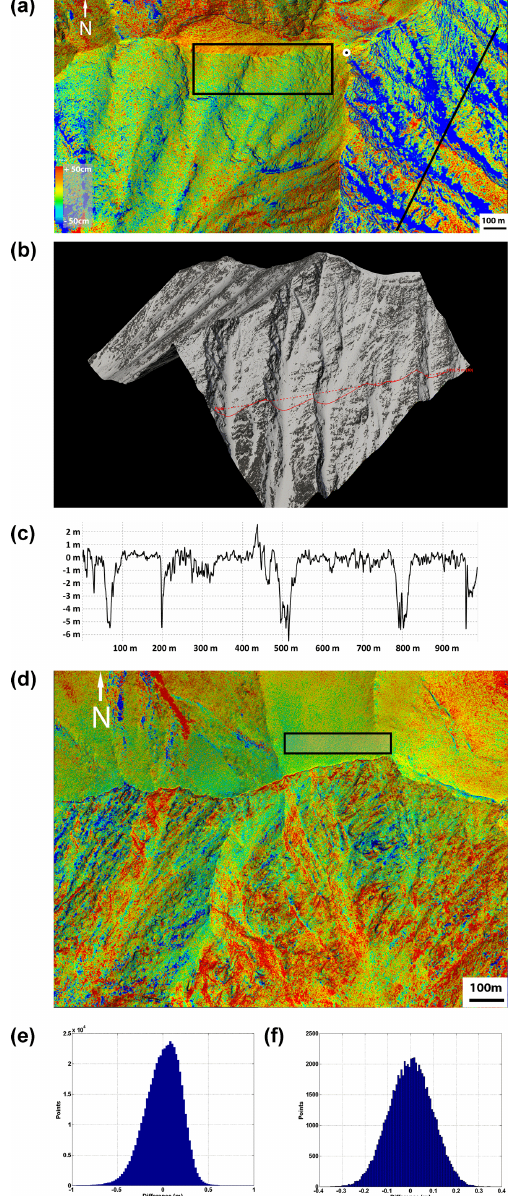
Figure 3. Precision assessments. (a) Difference in elevation between March and April 2014 acquisitions at Mt. Chamberlin, shown as a top view with slight sun shading to highlight underlying topography. Color represents change ( − 50 to + 50cm). The consistency of color shift between mountain faces is not due to a spatial misalignment of the data but rather to substantial, real changes that are dependent on aspect, as described in the text. Such real changes confound our repeatability estimates which assume no change on the ground. (b) 3-D oblique view of domain in (a) , draped with orthoimage from April, indicating the locations of snow-filled gullies on the southeast face. Profile line is shown as both a straight line and terrain hugging line and is about 1000m long, crossing five gullies. (c) Profile of elevation difference (that is, data in a ), revealing patterns of snow redistribution. Much of the snow that had recently fallen in March avalanched out of the gullies, leaving them up to 6m deeper in April. Note that the ridges in between show little to no change, qualitatively indicating the high quality of the data and the technique’s suitability for measurement of snow depth in steep terrain. (d) Difference in elevation between March and April 2014 acquisitions at Mt. Isto, with same coloration as (a) . Again, there is substantial real change between acquisitions, but less than in (a) . Histogram of differences of elevations calculated from boxes in (a) and (e) shown in (d) and (f) respectively over smoother glacier surfaces. Both are roughly gaussian with 95% of points within ± 38 and ± 20cm. Inspection of orthoimages here reveals that real changes are still occurring on the glaciers in these smaller domains, but there are no large locations that have less change, so these estimates of precision are conservative as they are confounded by real